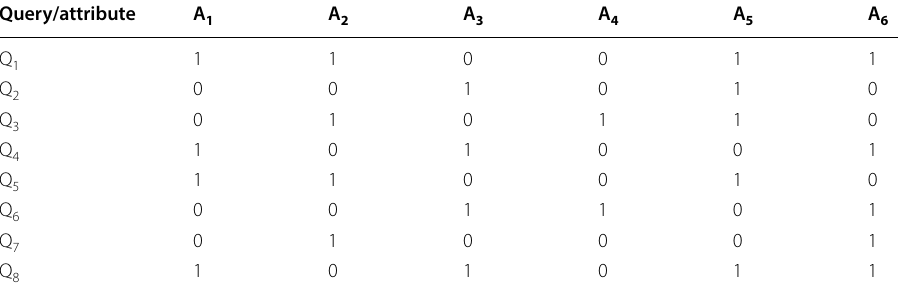
Table 3 Attribute Access Matrix (AAM)